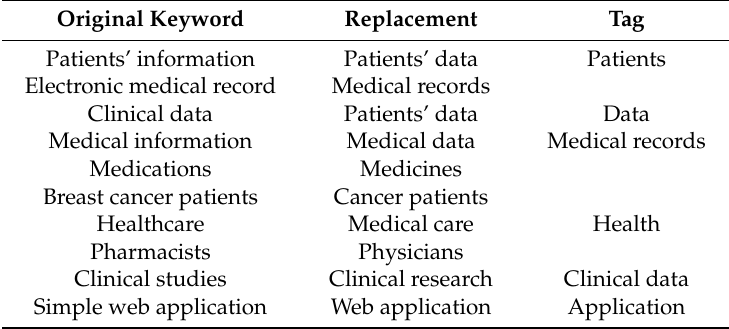
Table 2. Examples of 10 keyword pairs based on their semantic